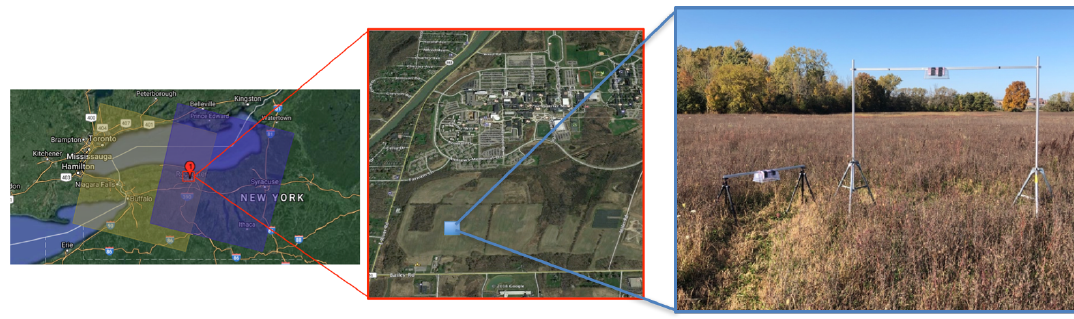
Figure 6. The target for the preliminary radiometer measurements is a grassy field located on the RIT campus in Rochester, NY. It is located in an overlap of two Landsat passes, allowing for twice the collects during a 16 day